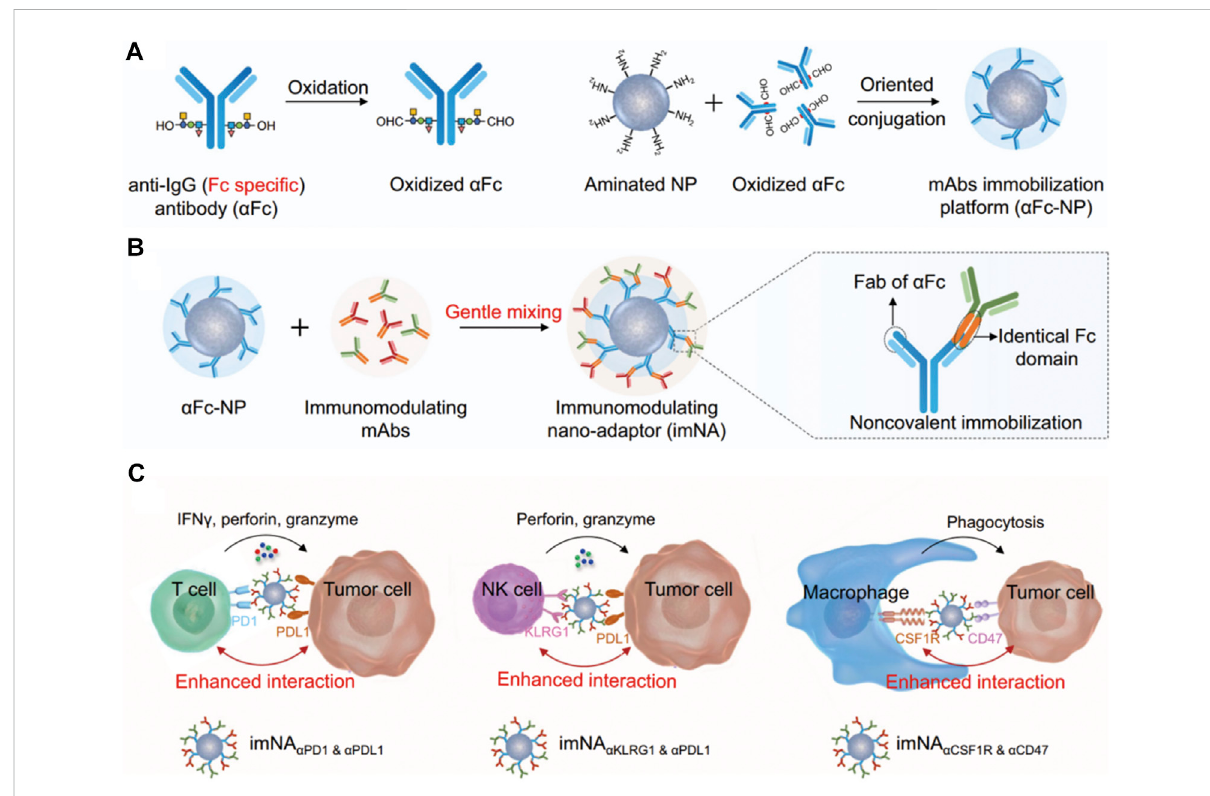
FIGURE 5 (A – C) Schematic illustrating the design of imNAs and their potential to improve antibody-based cancer immunotherapy (Jiang et al.,